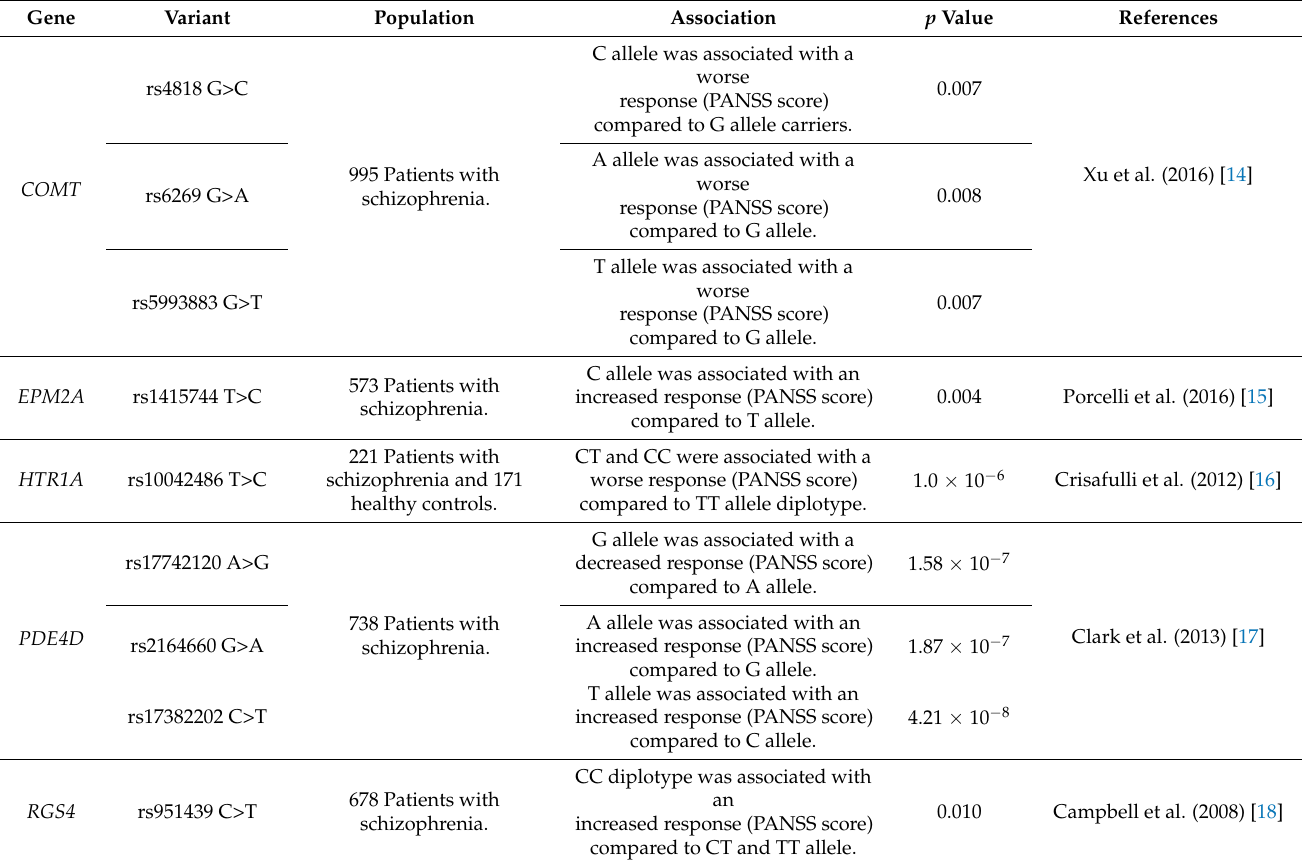
Table 2. Association between gene variants and their effect on drug efficacy